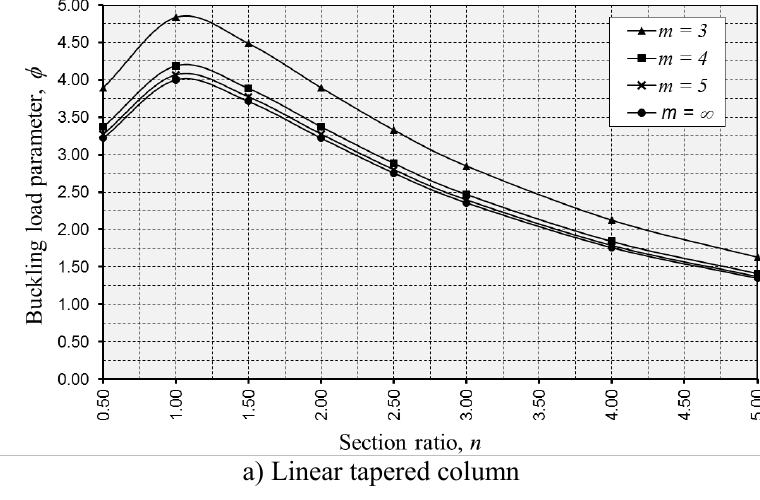
Fig. 4. Buckling load parameter of tapered columns with clamped-pinned